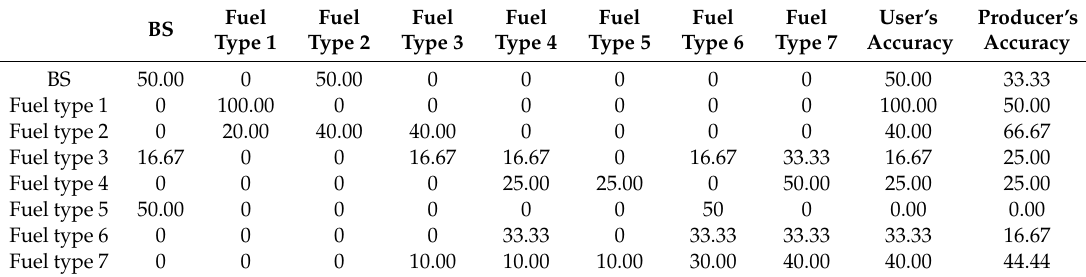
Table 10. Confusion matrix for the most accurate classification model using Sentinel-2 data after validation. Values are showed in %. BS stands for bare soil.